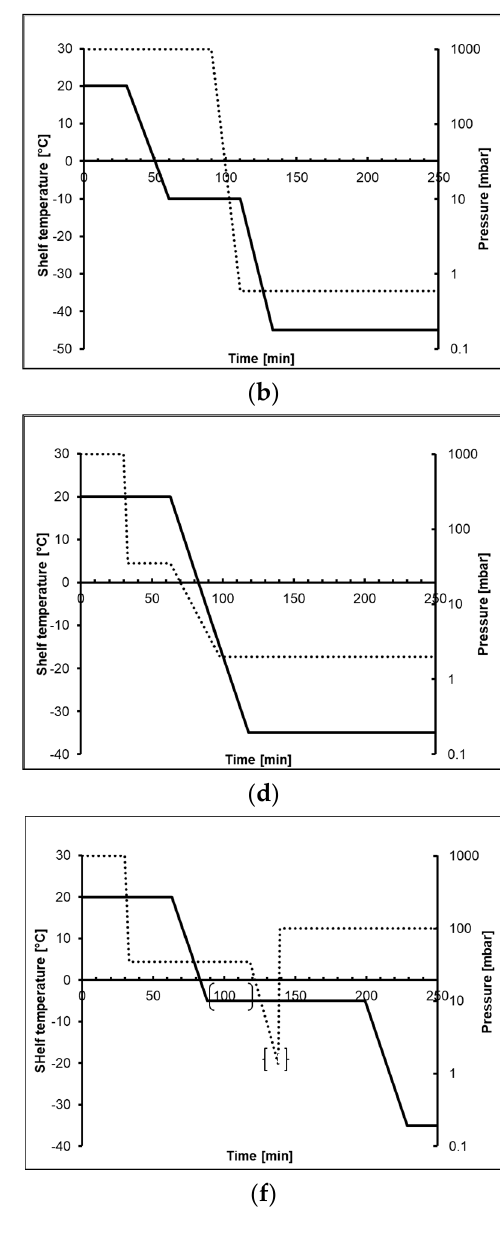
Figure 2. Overview of freezing parameters from the literature, using vacuum-induced surface freezing and proposed optimized parameters from the present study. ( a ) Kramer et al. [16]; ( b ) Liu et al. [5]; ( c ) Oddone et al. [17]; ( d ) Hof et al. [18]; ( e ) Allmendinger et al. [19]; and ( f ) optimized freezing parameters. To compare cycle times, each cycle was adjusted from the literature references to start with equilibration for 30 min at 20 °C (loading temperature). ( ) = equilibration time, dependent on fill volume; { } = closing of the isolation valve.